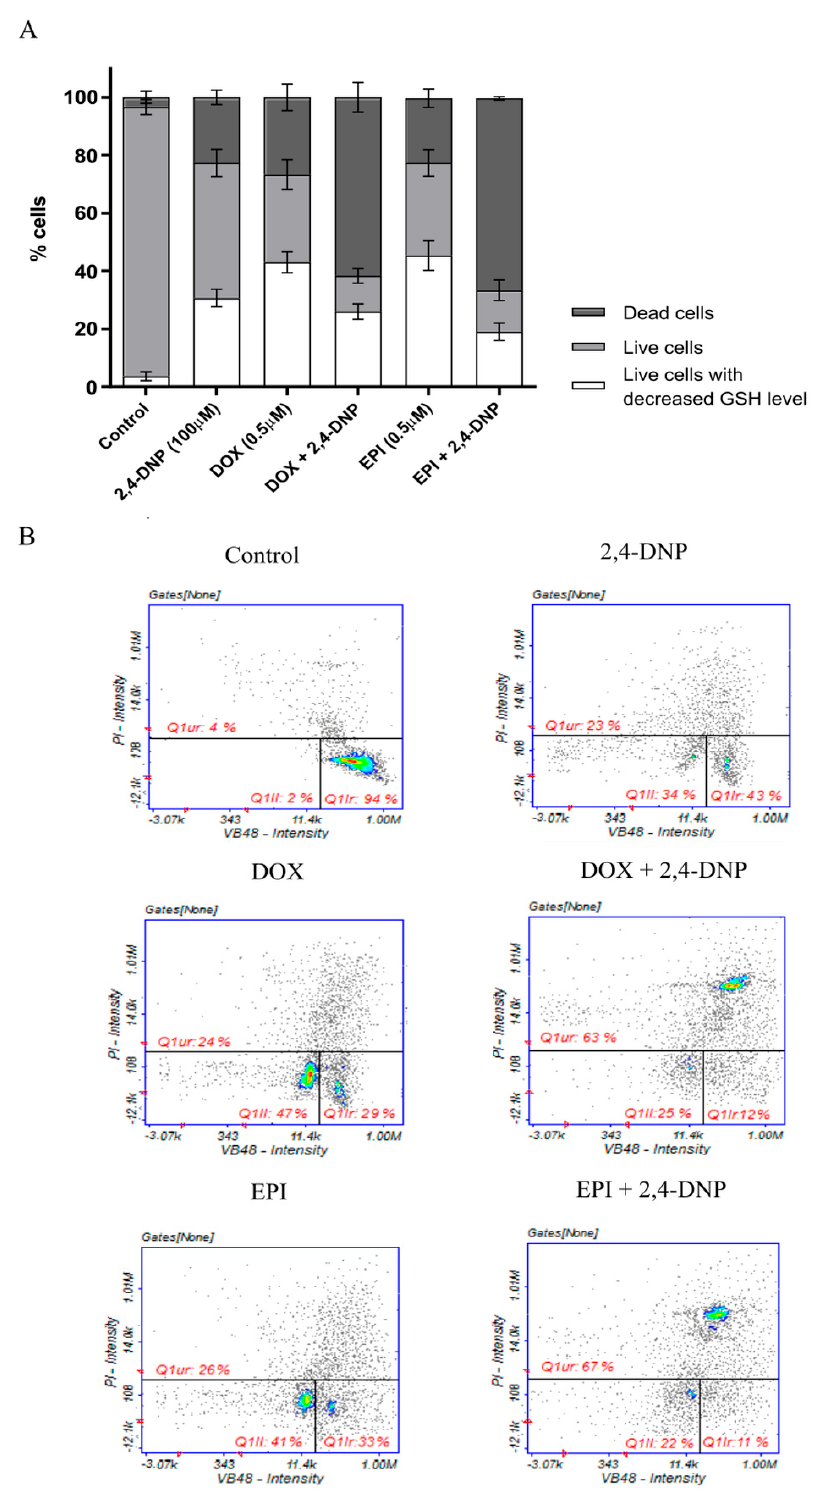
Figure 8. ( A ) Detection of the level of cellular thiols in LNCaP cells by image cytometry. The cells were treated for 24 h with 2,4-DNP, DOX and EPI or combined (2,4-DNP + EPI, 2,4-DNP + DOX).